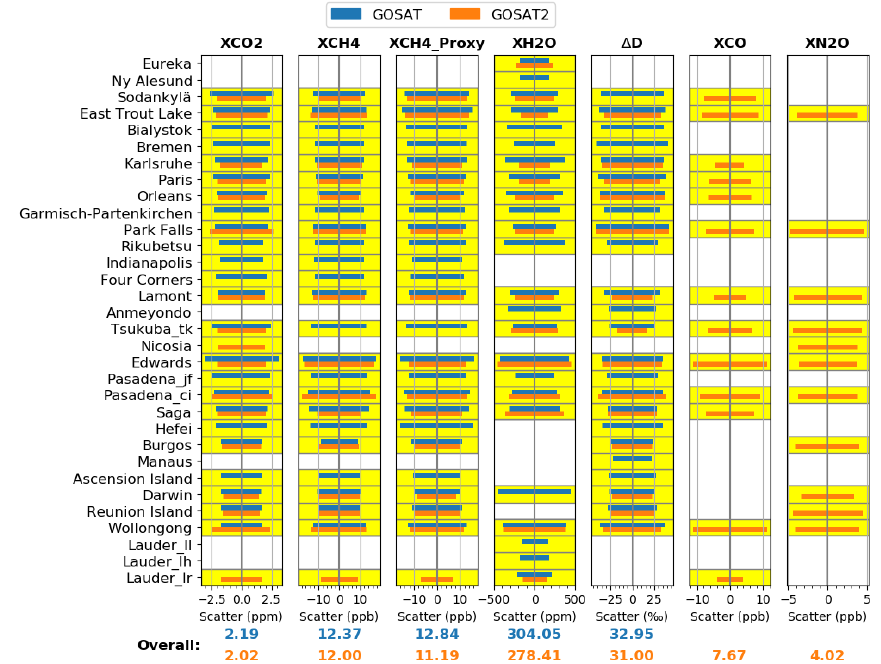
Figure 14. Scatter of FOCAL data products for GOSAT (blue) and GOSAT-2 (orange) at different TCCON stations. Involved stations for each product are marked by a yellow background. See Table 6 for a summary of all TCCON validation